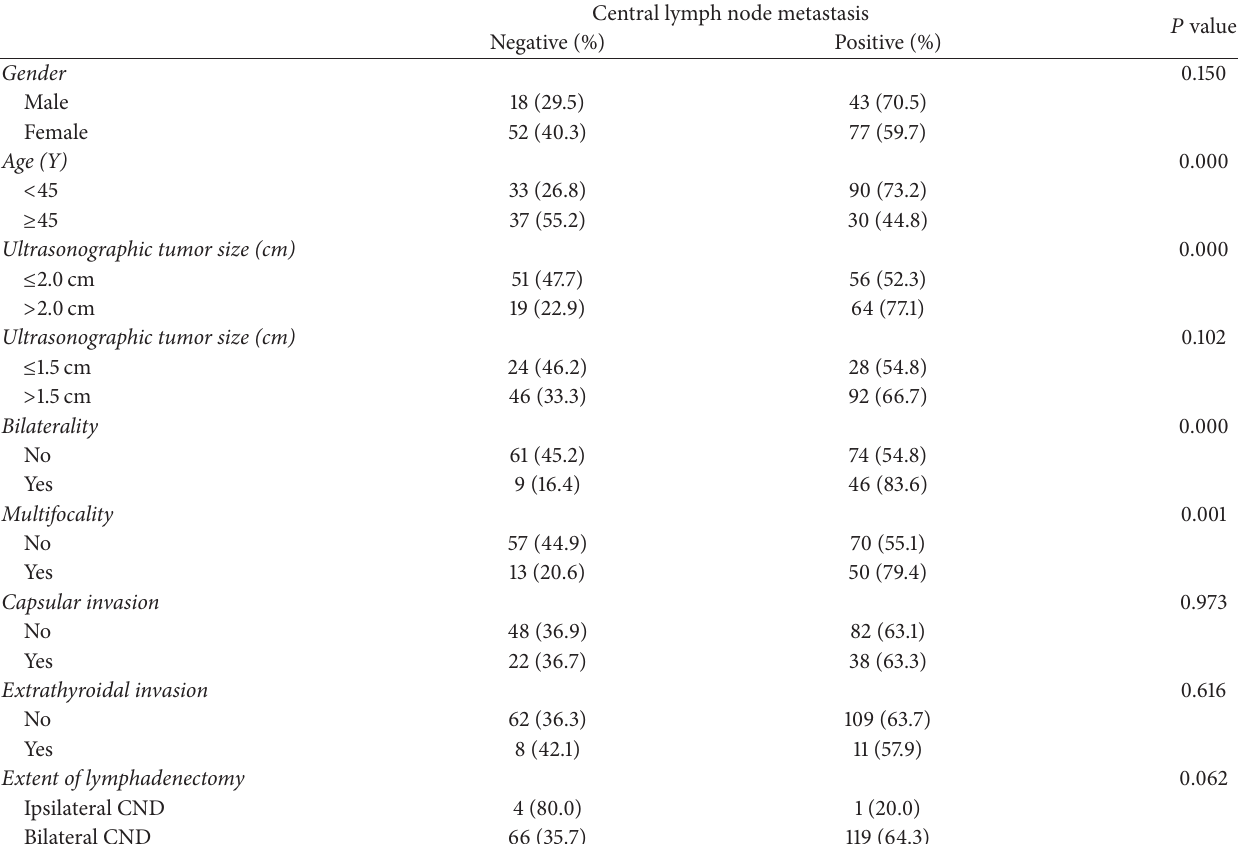
Table 1: Univariate analysis of the correlations between CLNM and clinicopathologic characteristics of cN 0 CPTC.